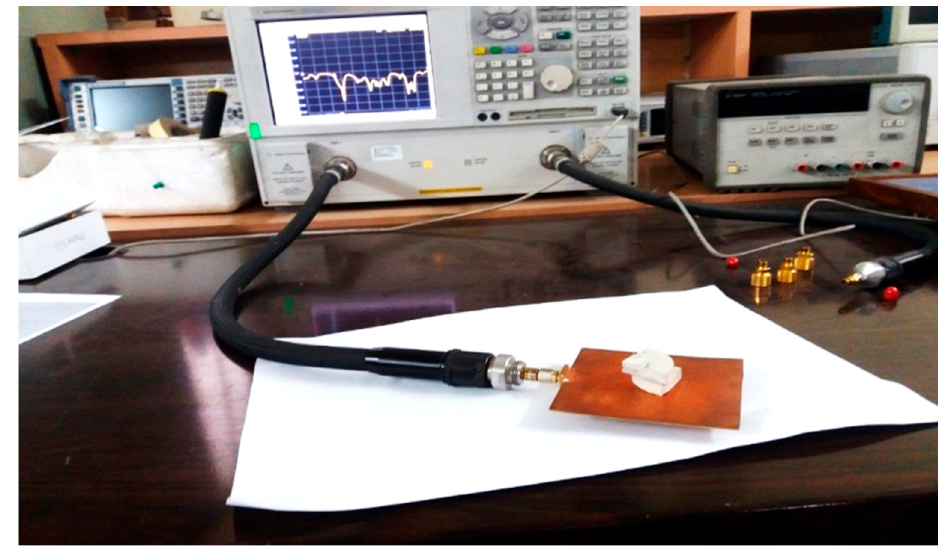
Figure 5. The hardware of the 3.5 GHz aperture coupled MSDRA, measurements with a VNA.